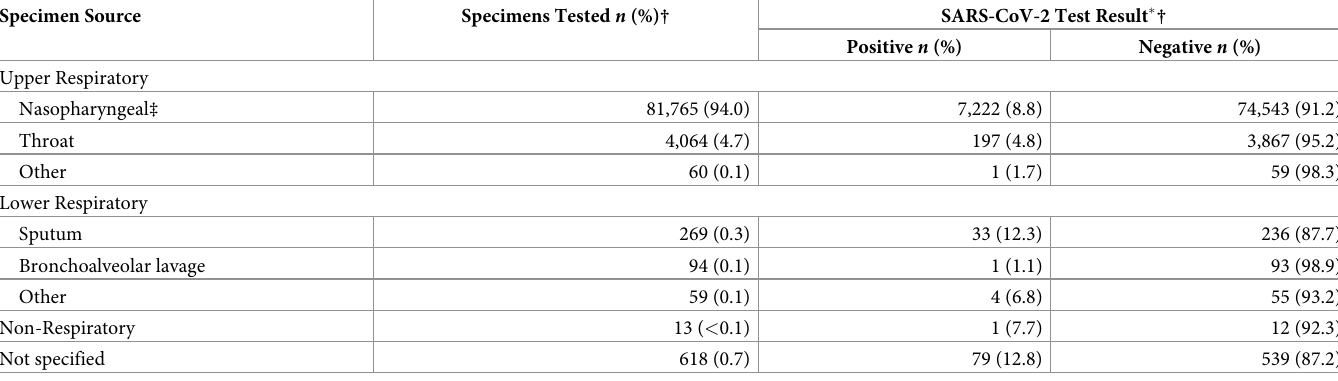
Table 2. SARS-CoV-2 molecular-based � test results by specimen type. Specimens received January 11, 2020 –April 22, 2020 ( n = 86,942) and tested at Public Health Ontario with valid results. Specimen Source